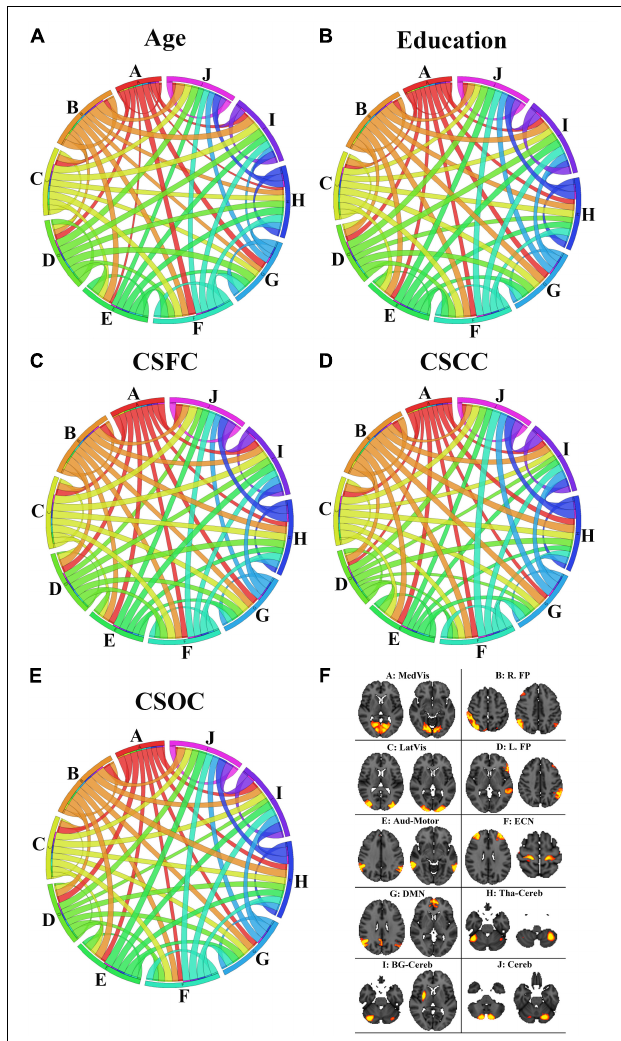
FIGURE 9 | The contribution of the RSFCs to the estimation of age (A) , education (B) , CSFC (C) , CSCC (D) , and CSOC (E) . The circular diagram indicates the relative contribution of the functional networks, with each functional network indicated by one color. The networks are the medial visual network ( A : MedVis), the right fronto-parietal network ( B : R. FP), the lateral visual network ( C : LatVis), the left fronto-parietal network ( D : L. FP), the auditory motor network ( E : Aud-Mot), the executive control network ( F : ECN), the default mode network ( G : DMN), the thalamus cerebellum network ( H : Tha-Cereb), the basal ganglia cerebellum network ( I : BG-Cereb) and the cerebellum ( J : Cereb). Two typical spatial maps of each network can be found in subfigure (F) . Each ribbon links two functional networks, and the ribbon size scales with the contribution of the RSFCs between the networks it